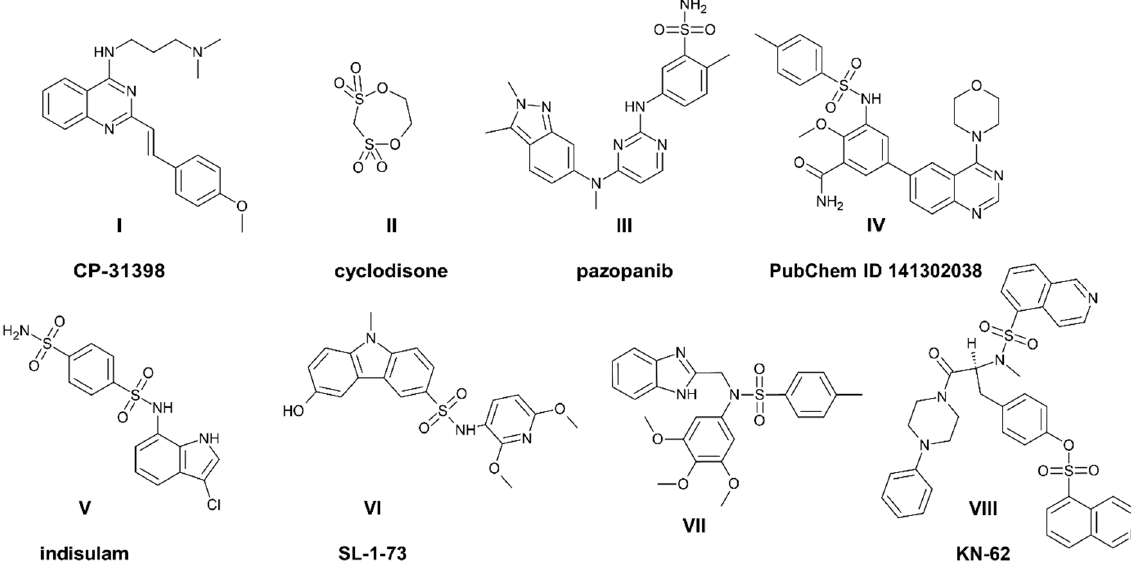
Figure 1. Quinazolines and sulfonyl derivatives with an anticancer activity. Structure ( I )—reactivator of p53, known as PRIMA-1. Structures ( II ) and ( III , V ) are drugs used in anticancer therapy. Compounds ( IV ) and ( VI , VIII ) are preclinical drugs. Structure ( VII ) is potent anticancer sulfonamide described in [19] .